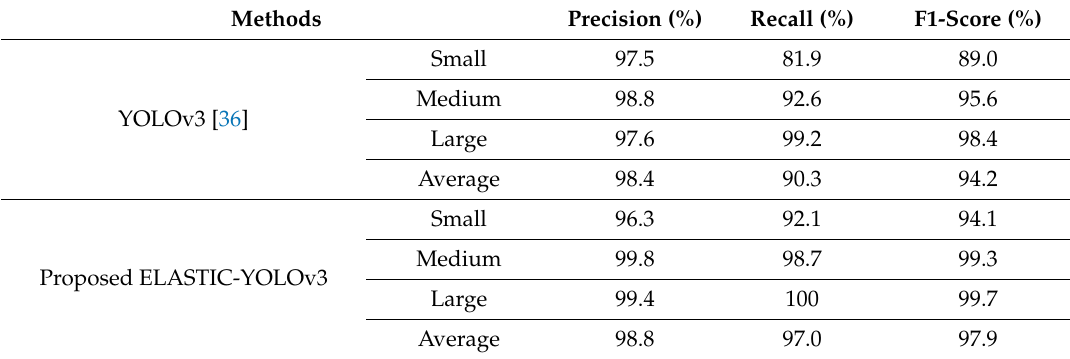
Table 2. Comparison of the precision, recall, and F1-score according to the size of fire regions for the proposed ELASTIC-YOLOv3 and original YOLOv3 [19] using the NightFire-DB.